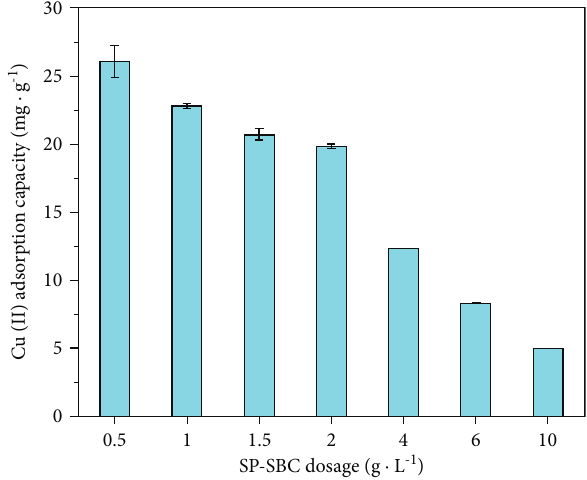
Figure 6: E ff ect of SP-SBC dosage on the adsorption capacity of SP-SBC for